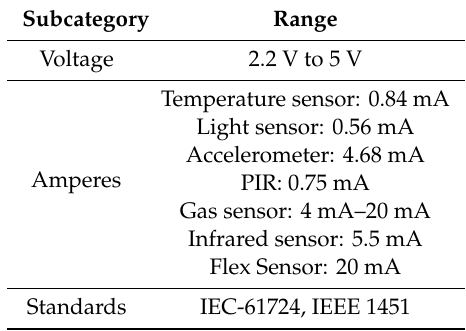
Table 10. Generic specifications of sensors.